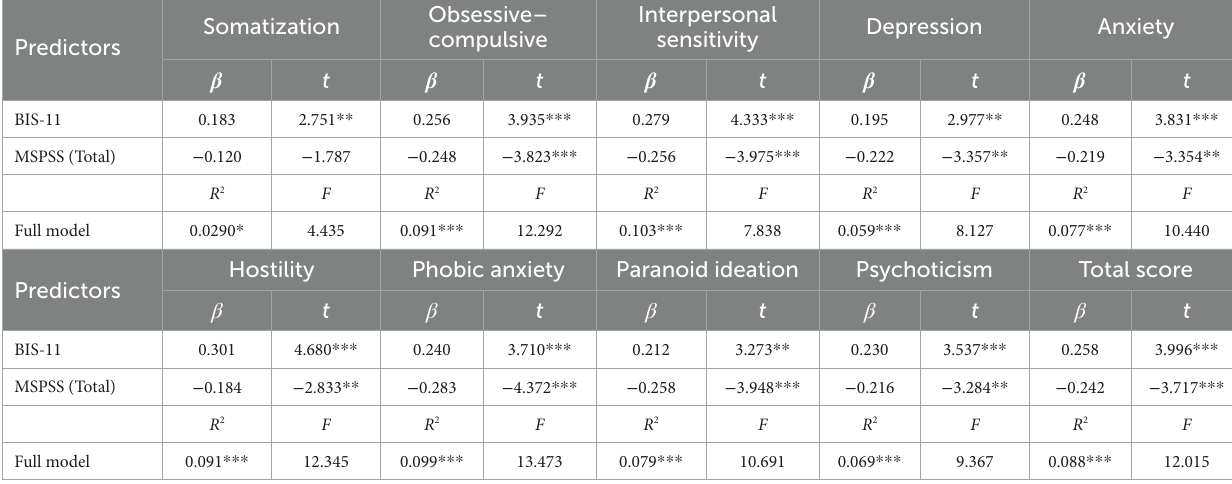
TABLE 4 The multivariable linear regression of BIS-11, MSPSS and each Dimension of